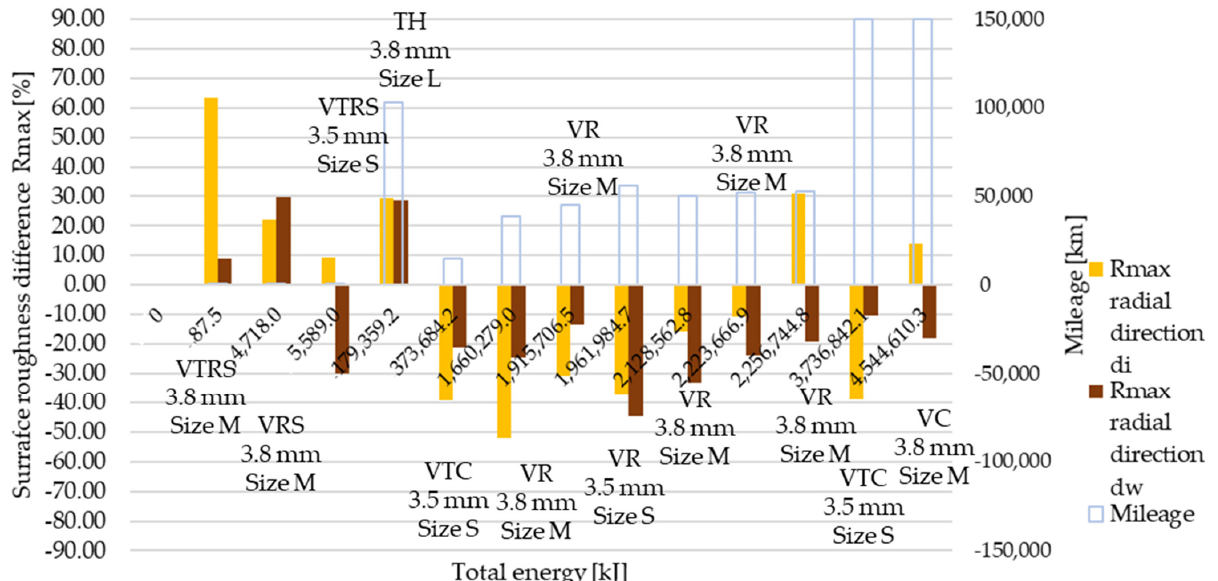
Figure 15. Deviation of Rz surface roughness values from initial conditions, tangential direction.